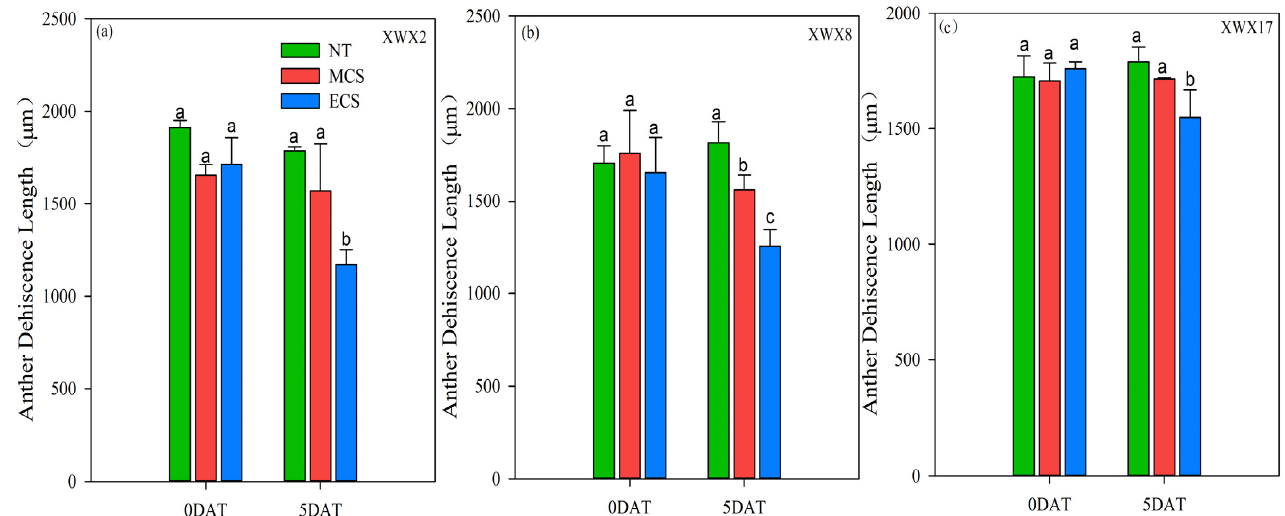
Figure 3. The anther dehiscence length of three inbred late varieties under different temperature treatments. ( a ) XWX2. ( b ) XWX8. ( c ) XWX17. DAT: Days after temperature treatments; XWX2: Xiangwanxian2; XWX8: Xiangwanxian8; XWX17: Xiangwanxian17; NT: Normal temperature control; MCS: Moderate chilling stress; ECS: Extreme chilling stress. Different lowercase letters denote statistical differences among treatments of a cultivar at the 5% level according to LSD test. Error bars above mean indicate standard error ( n = 3).